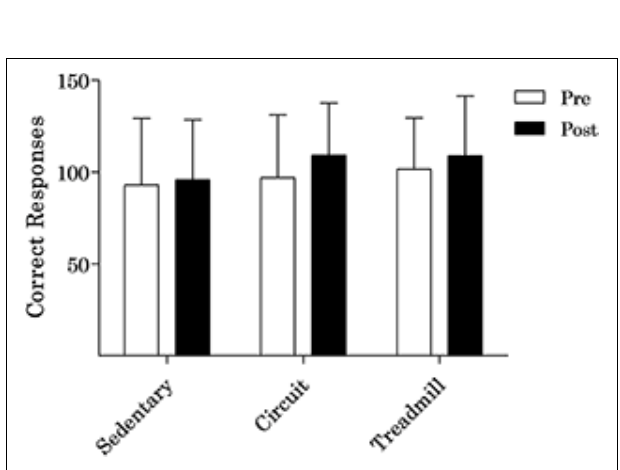
FIGURE 3 | Change in oxygenated hemoglobin in the prefrontal cortex by condition.